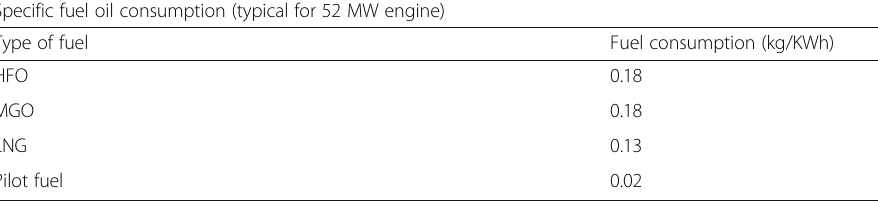
Table 7 Specific fuel oil consumption Specific fuel oil consumption (typical for 52 MW engine) Type of